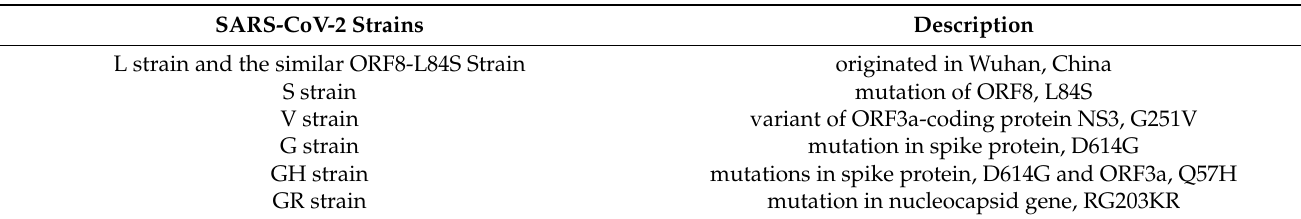
Table 1. SARS CoV-2 strains. G and GR variants are predominant in Europe, while GH is more common in North America.